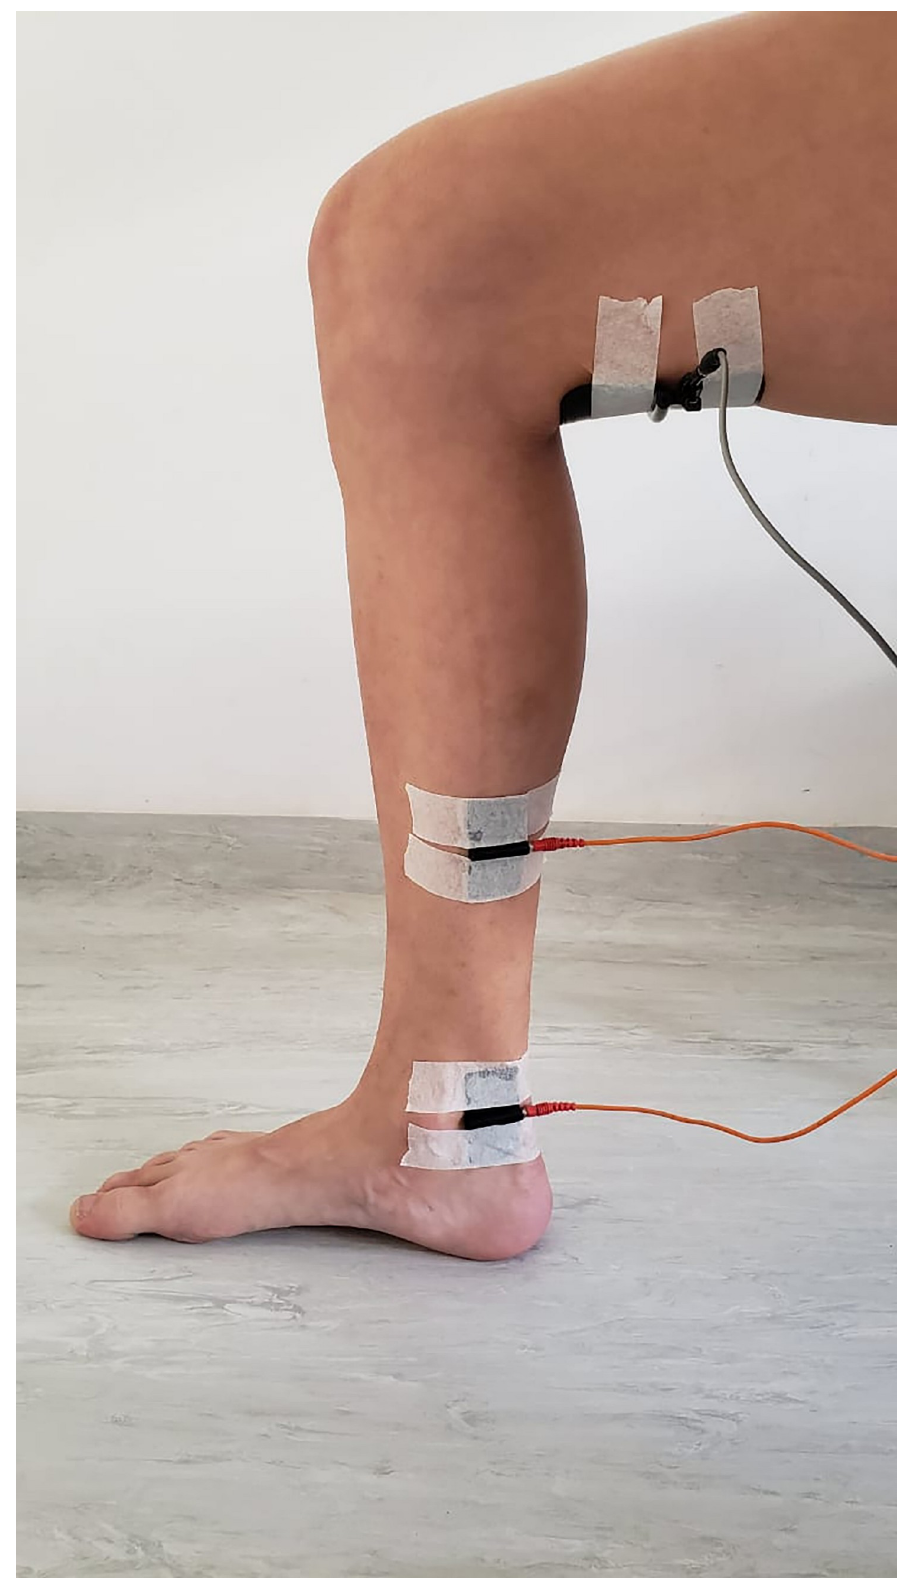
Fig 4. Positioning of the dispersive